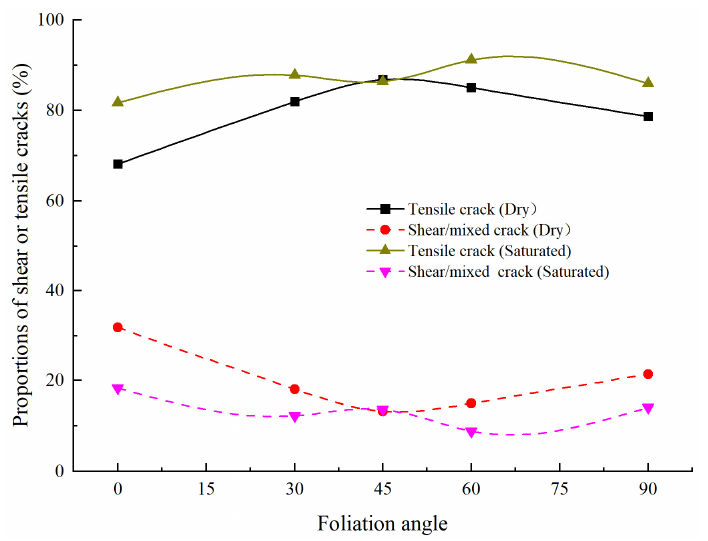
Figure 12. Comparison of the proportions of shear and tensile cracks for foliation phyllite with dif- ferent foliation angles. different foliation